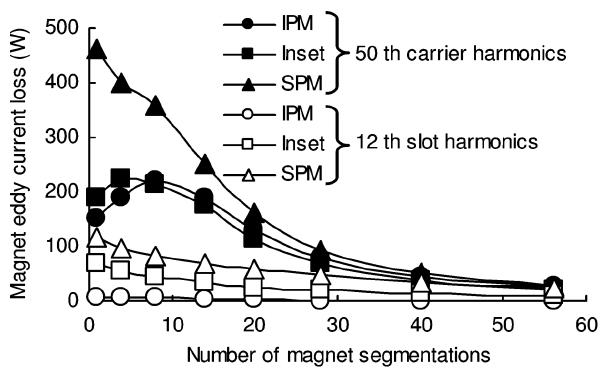
Figure 11. Magnet eddy current loss vs. segmentation for an example slot and carrier harmonic